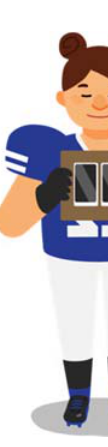
Figure 1. The two devices were affixed to the rigid device ‐ holder and participants were instructed to hold the device ‐ holder against their chest.